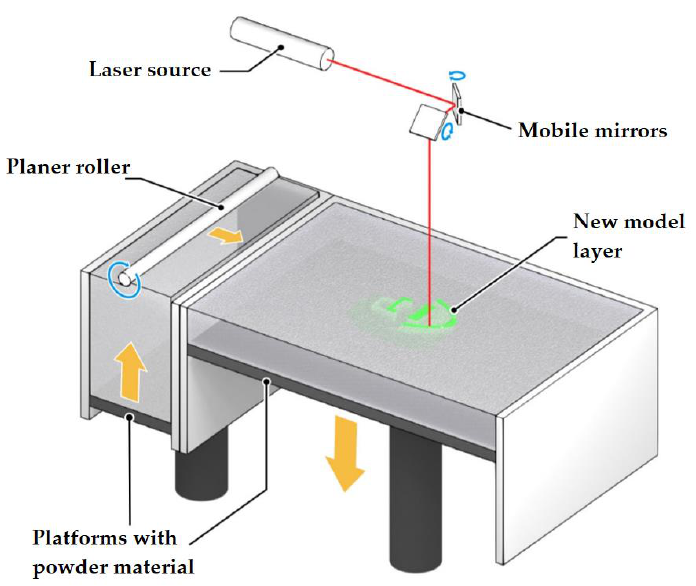
Figure 7. Selective laser sintering (SLS), a schematic diagram.